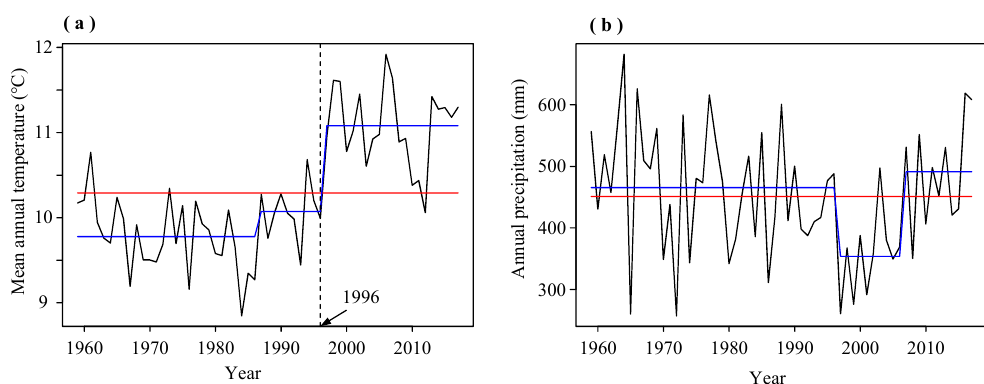
Figure 2. Annual mean temperature and annual precipitation during 1959–2017 around Mt. Guandi, Central China. ( a ) Mean annual temperature; ( b ) Annual sum of precipitation. The black dashed line marks the breakpoints with significant change. The red line indicates the mean value of the whole period, and the blue line shows the fitted levels by the identified breakpoints.